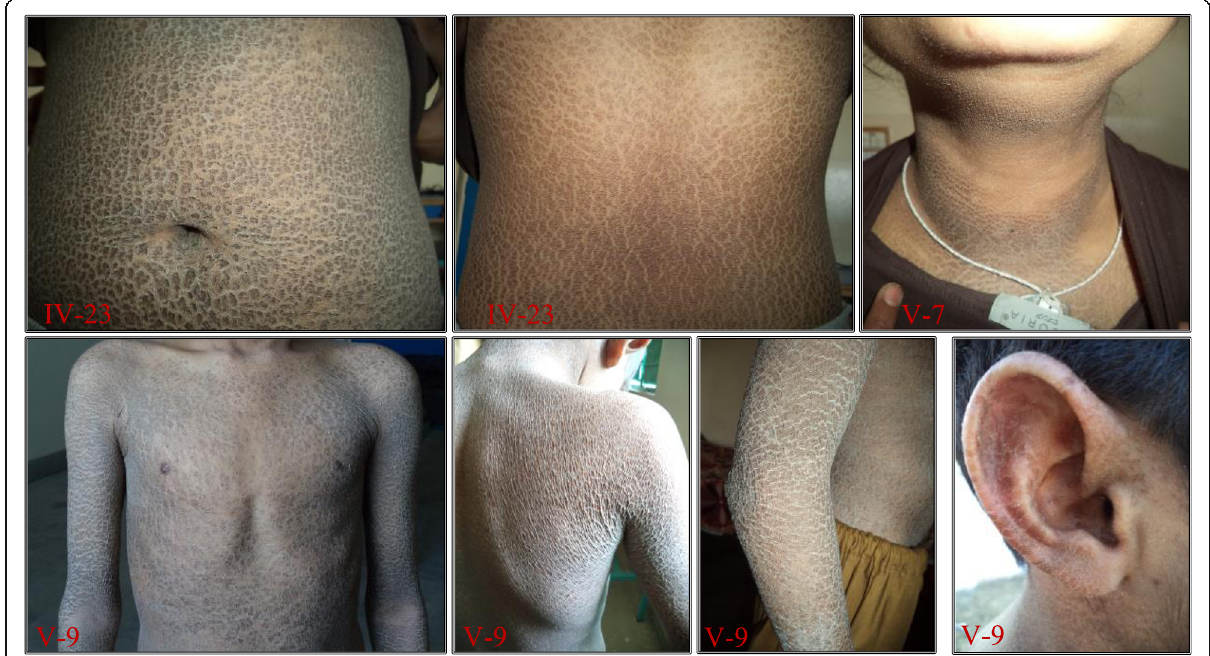
Fig. 2 Clinical findings of XLI patients. Photographs of skin showing thick, large, polygonal, dark-brown scales involving the trunk front and back, neck, arm and